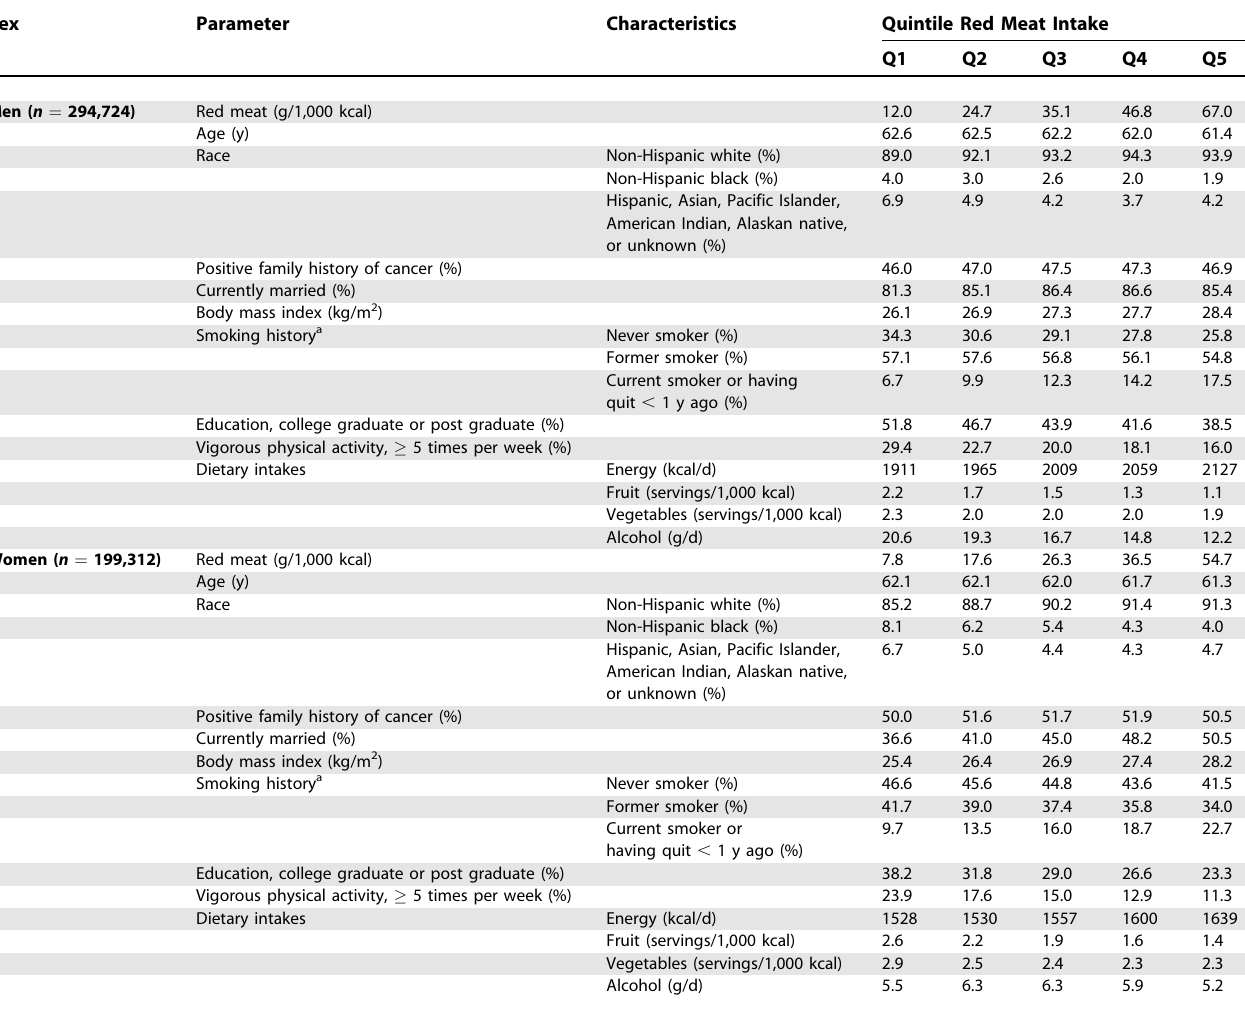
Table 1. Means and Proportions for Baseline Characteristics of the NIH-AARP Diet and Health Study Cohort ( n ¼ 494,036) by Red Meat Quintile Sex